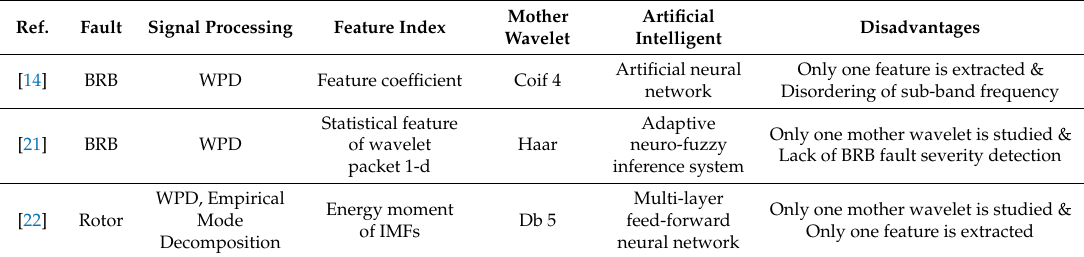
Table 1. A summary on selected criteria for fault detection using